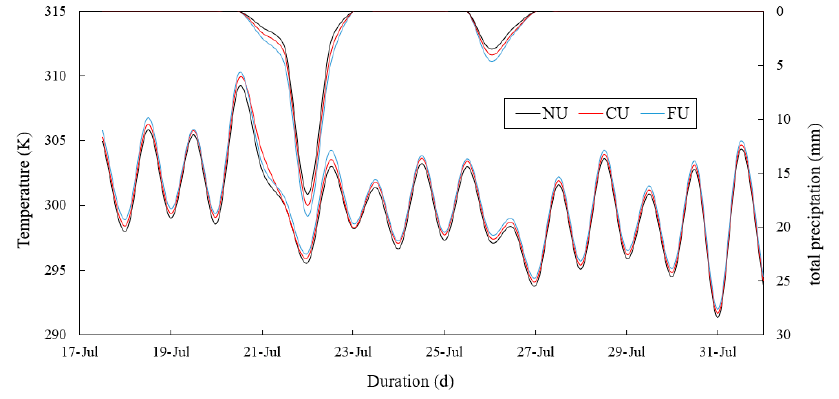
Figure 8. Diagram of mean rainfall and temperature variation with duration during the two weeks.